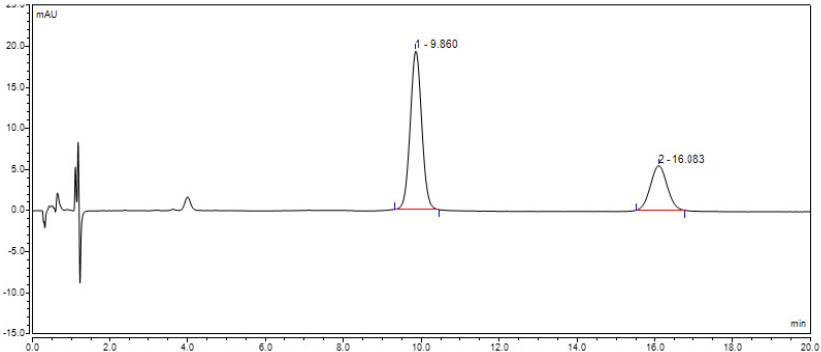
Figure 7. Chromatogram illustrating stable and degraded RSV peaks.